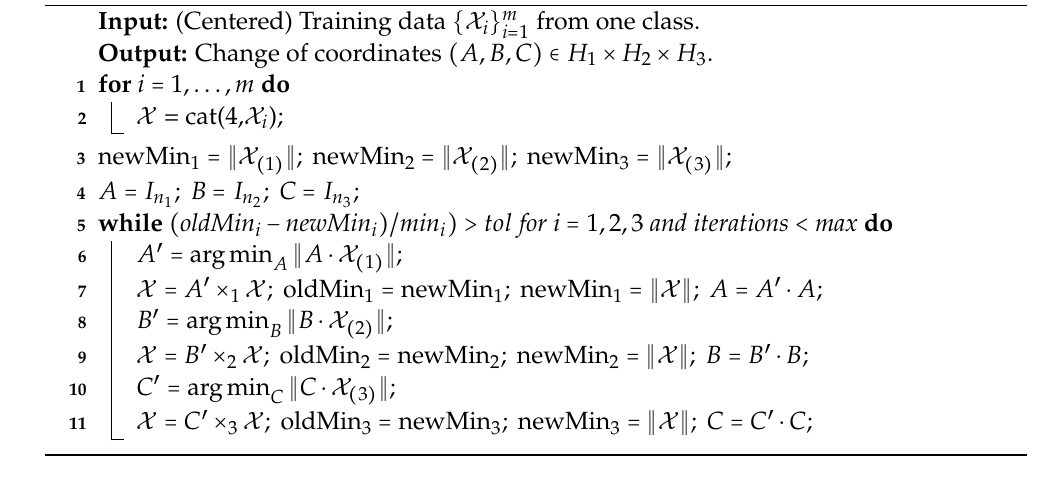
Algorithm 1 New sets of coordinates.